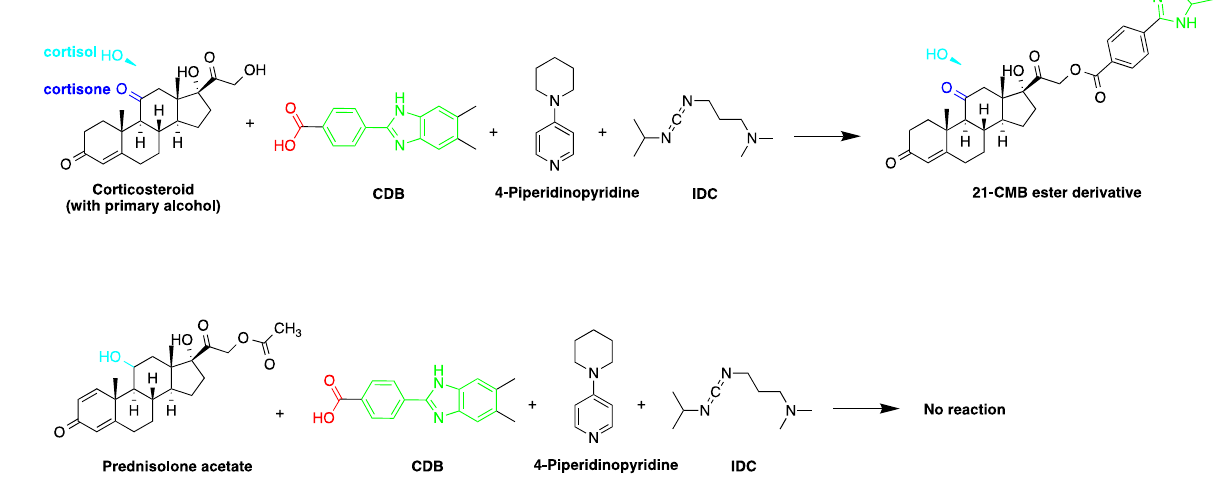
Figure 4. Esterification of primary alcohol functionality of cortisol and cortisone by 2-(4-carboxyphenyl)-5,6-dimethylbenzimidazole (CDB) in the presence of 4-piperidinopyridine and 1-isopropyl-3-(3-dimethylaminopropyl) carbodiimide (IDC) perchlorate. Prednisolone secondary alcohol shows no reaction.